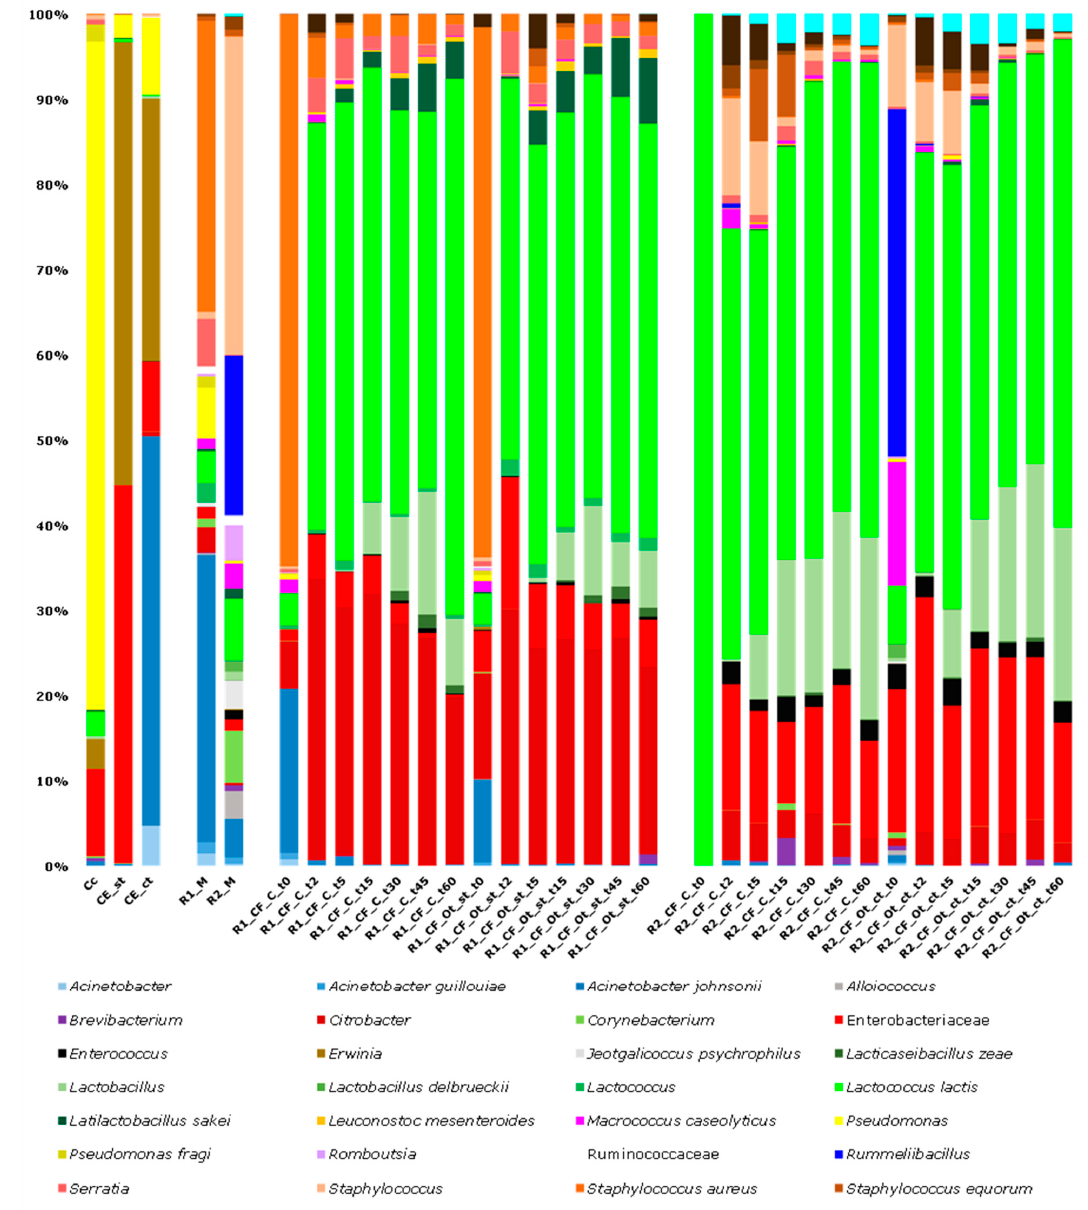
Figure 4. Relative frequency of the bacterial ASVs detected by Illumina DNA sequencing in thistle- based coagulants (Cc, CE_st, CE_ct), raw milk (R1_M, R2_M), control (CF_C), and experimental (CF_Ot_st and CF_Ot_ct) cheeses sampled during ripening. Only ASVs with an incidence above 1% in at least two samples are shown.